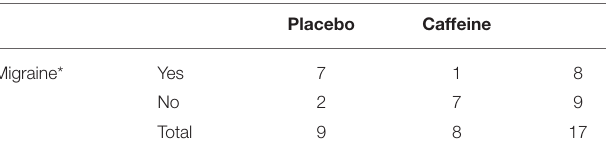
* Comparing caffeine withdrawal (placebo) with caffeine (continuation or reintroduction) as atrigger, the Chi square with the use of Yates’ correction gives a significant difference (X 2